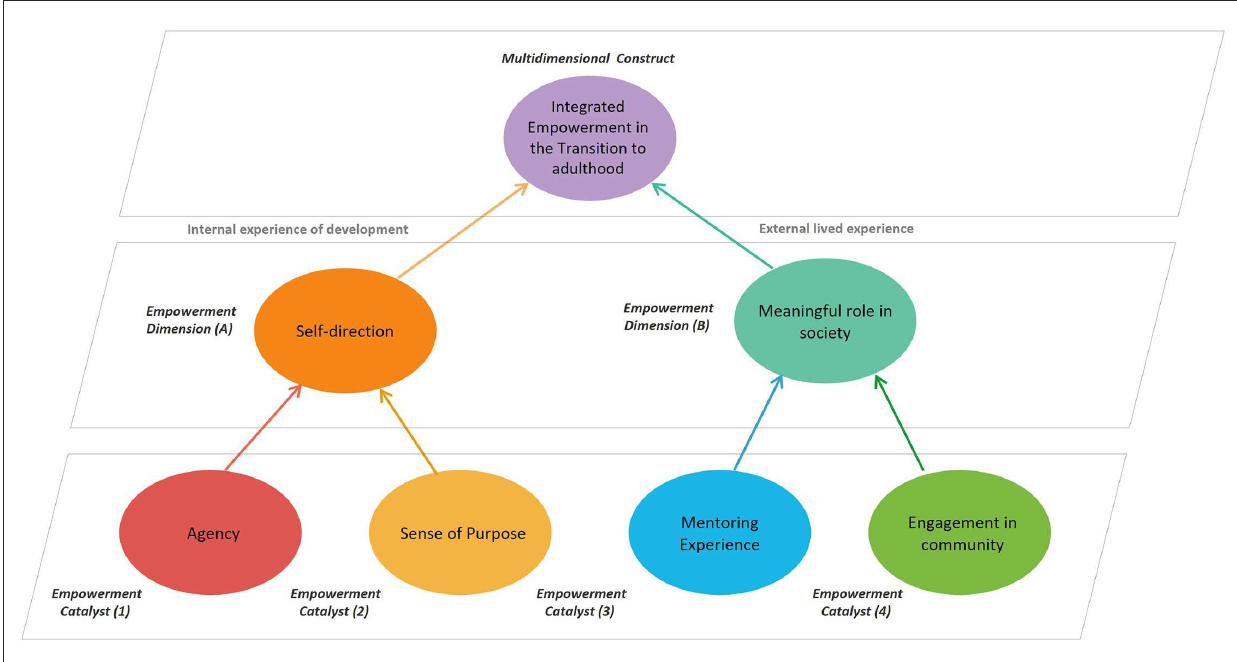
FIGURE1 Model of the integrated empowerment theory: transition to